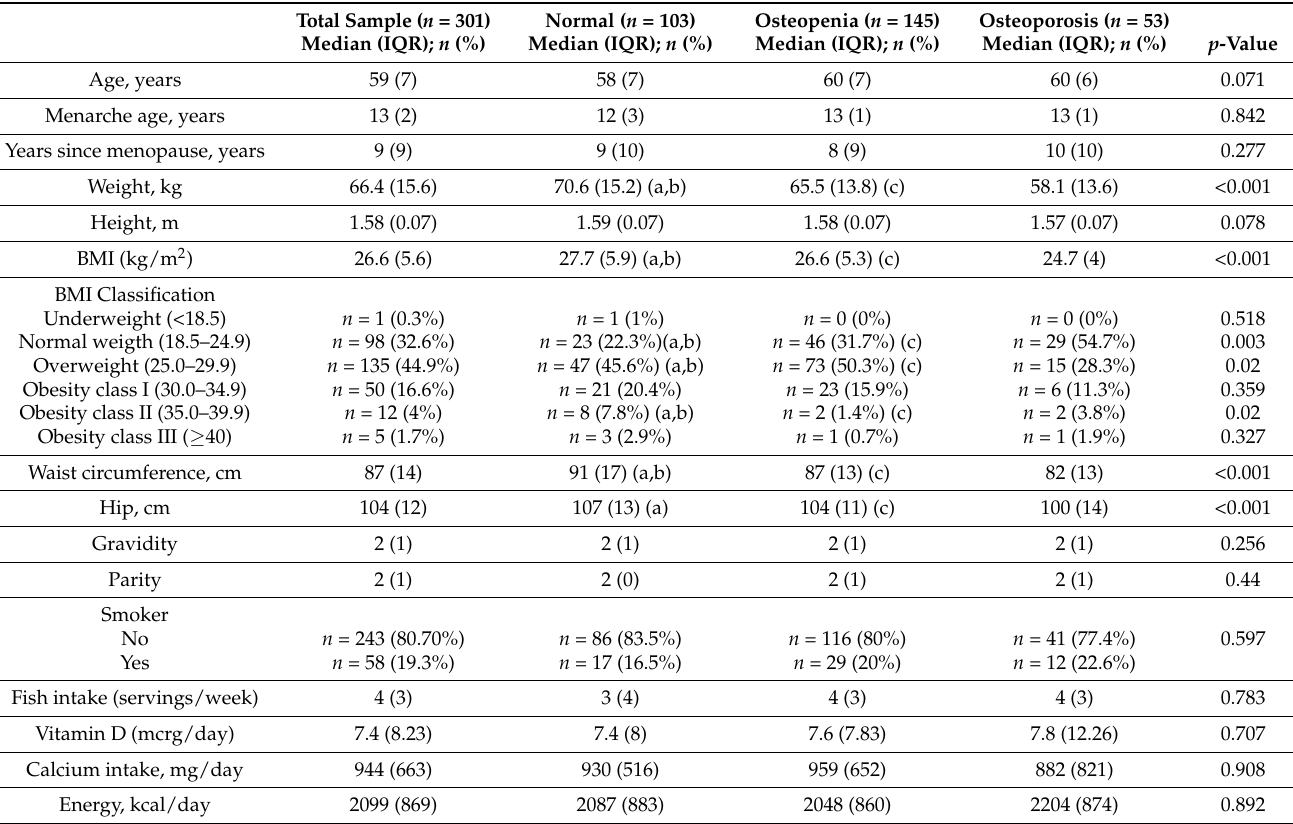
Table 1. Anthropometric, biological, dietary and lifestyle characteristics in the study